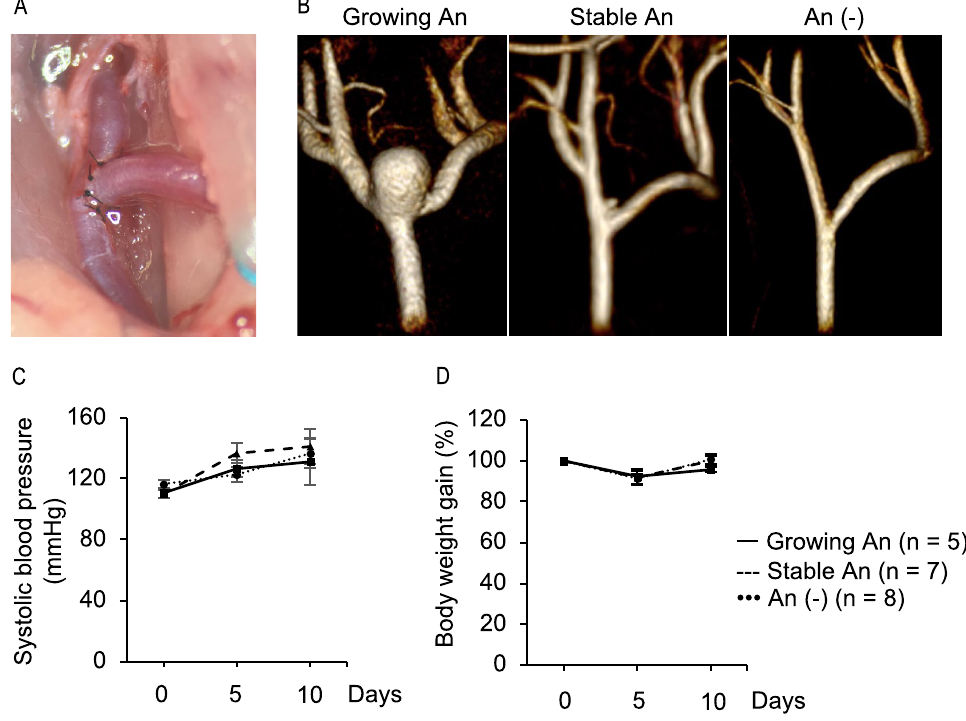
Figure 2. Present saccular aneurysm model at the surgically created common carotid artery (CCA) bifurcation in rats. ( A ) A macroscopic view of the surgically created CCA bifurcation. ( B ) Representative magnetic resonance angiography findings of the CCA bifurcation one month after aneurysm induction demonstrating the three categories: a growing aneurysm (An) (the left panel), a stable An (the middle panel), and no An (the right panel). These images were created using Horos visualization software (64-bit, version 3.6.6, https:// horos proje ct. org). Systolic blood pressure ( C ) and body weight ( D ) before and on the 5th and 10th days after aneurysm induction. Data are presented as means ± SD. Statistical comparisons were performed by the Steel-Dwass test at each time